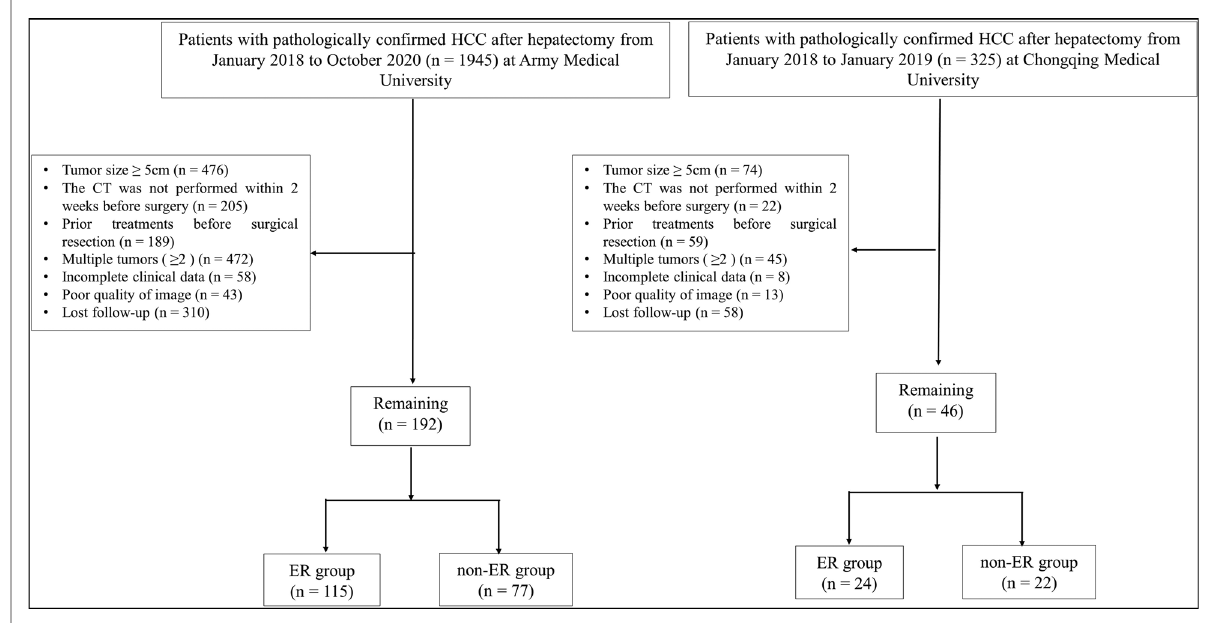
FIGURE 2 Flowchart of retrospective patient selection of HBV-related HCC in two